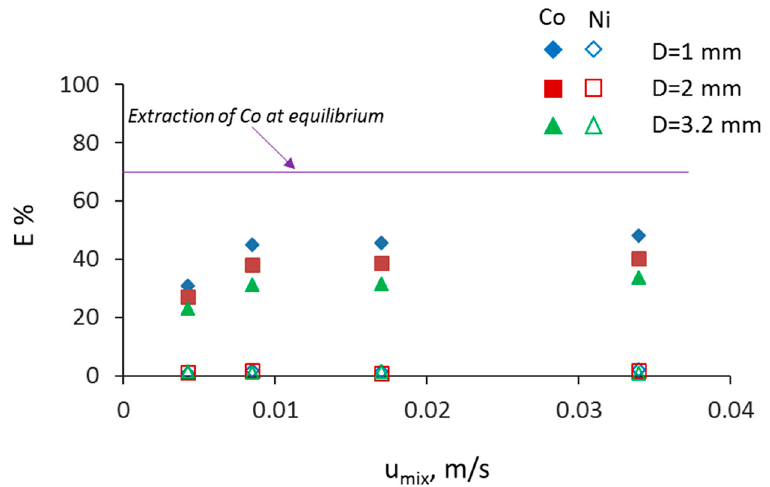
Figure 7. Extraction percentage of Co(II) and Ni(II) as a function of mixture velocity (Q tot ) at different channel sizes at constant residence time (t = 10 s).